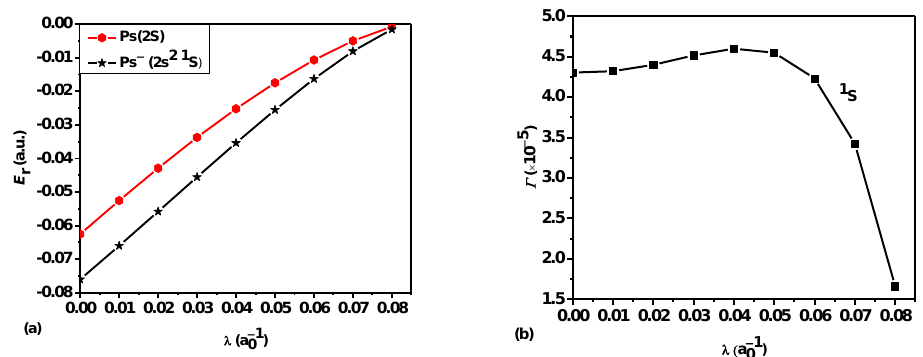
Figure 3. ( a ) Plot of the lowest 1 S e resonance energy 𝐸 𝑟 of Ps − as a function of 𝜆 . ( b ) Plot of the resonance corresponding resonance width 𝛤 of Ps − as a function of 𝜆 .